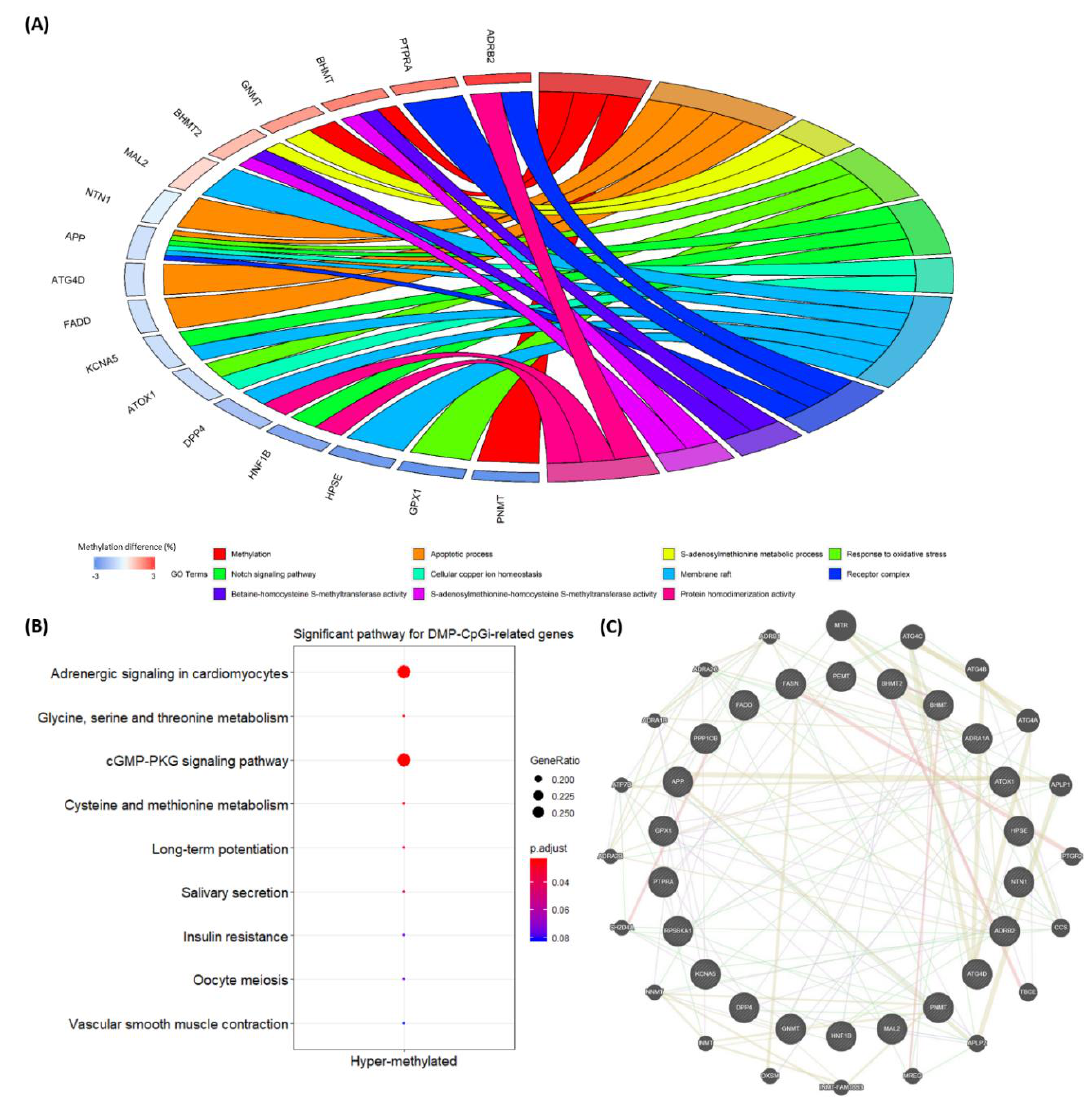
Figure 6. ( A ) Circo plots of relationships between 80 DMP-CpGi-related genes and 19 significant GO terms ( P -value < 0.05). Note: Methylation difference (%) refers to the difference in methylation levels of DMP-CpGis between the low and high BT groups. ( B ) Dot plots for significant pathways (p.adjust < 0.05). ( C ) Gene–gene networks.